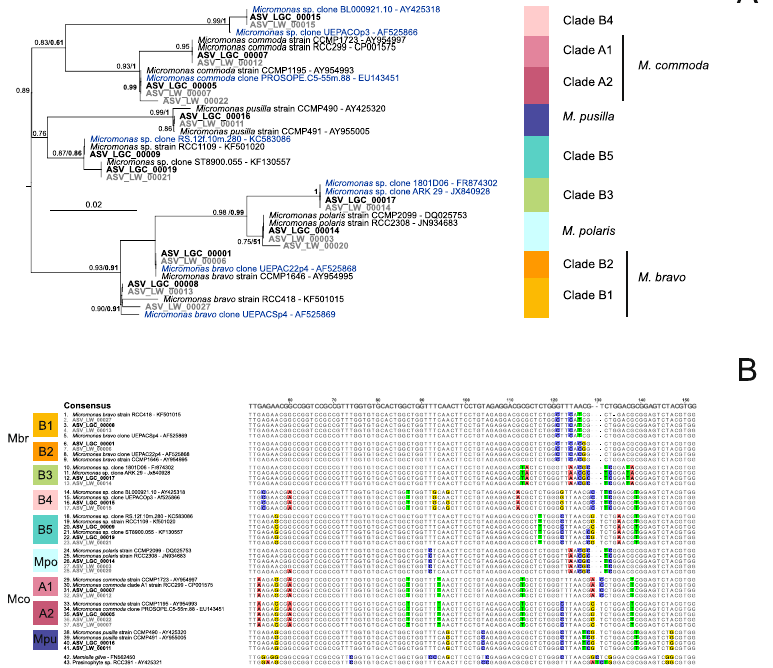
Figure 4. Phylogenetic diversity within the genus Micromonas . ( A ) Phylogenetic tree of 39 Micromonas sequences from the V4 region of the 18S rRNA gene (FastTree). The tree was rooted with Mamiellales (RCC391, AY425321 and Mamiella gilva , FN562450). Legend as in Fig. 2. ( B ) Alignment of 39 Micromonas V4 regions: the alignment is 327 bp long, but only the main signatures are shown (between positions 50 and 150 of the original alignment).